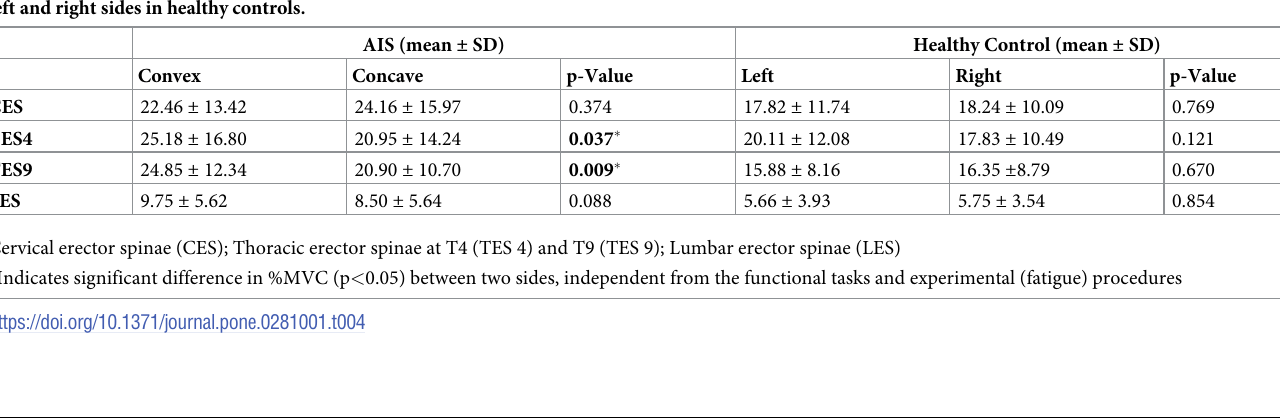
Table 4. Comparison of muscle activation (expressed in percentage of the maximal voluntary contraction [%]) between convexity and concavity in AIS group and left and right sides in healthy controls. AIS (mean ± SD) Healthy Control (mean ± SD) Convex Concave p-Value Left Right p-Value